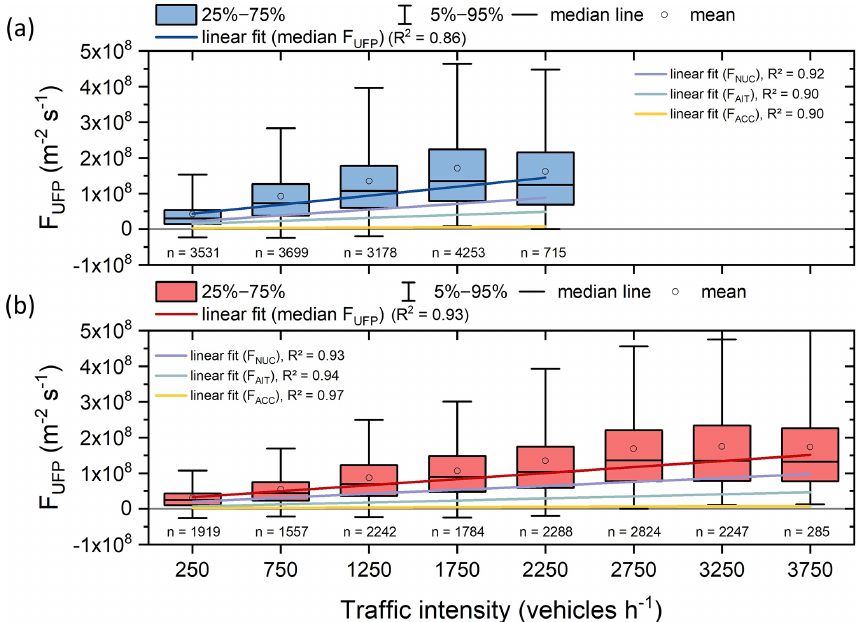
Figure 14. Relationship between F UFP and traffic intensity at (a) Hardenbergstraße (HS) and (b) Straße des 17. Juni (S17J). Linear regression lines for the particle mode fluxes F NUC , F AIT , and F ACC are